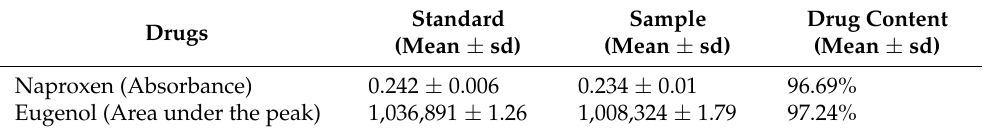
Table 6. Drug content of naproxen and eugenol from